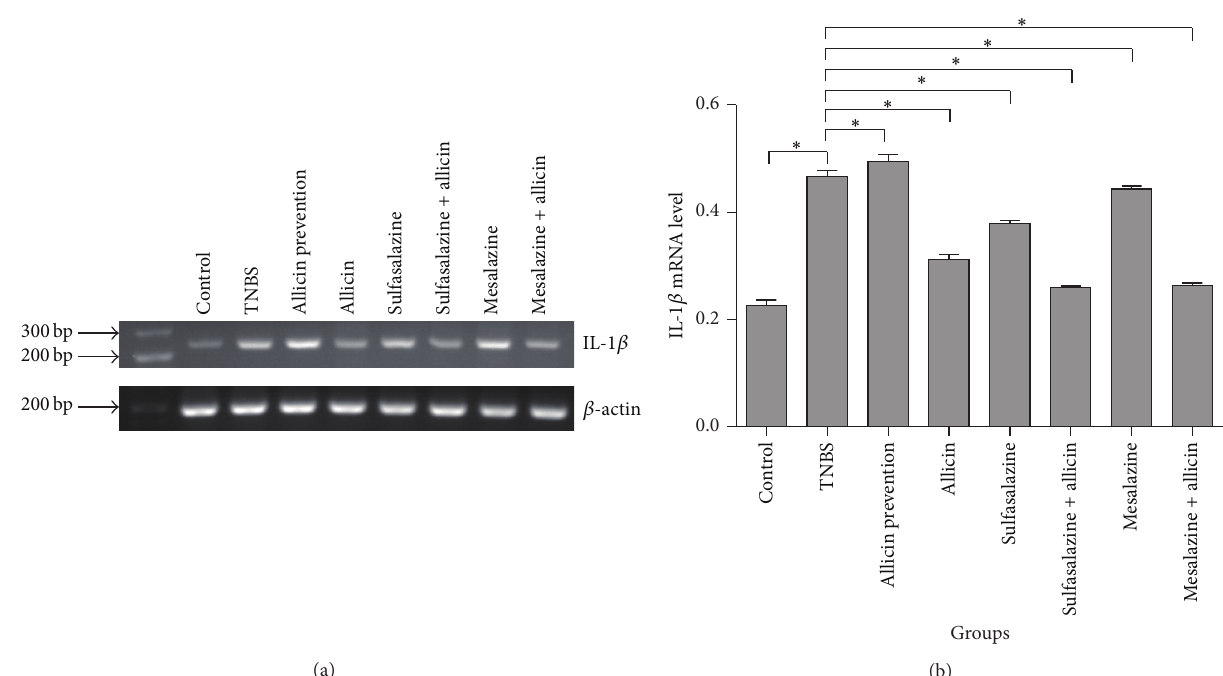
Figure 4: Expression of colon IL-1 𝛽 mRNA level in rats. (a) Total RNA was isolated from colon tissue. Colon IL-1 𝛽 mRNA levels were presented on an agarose gel. (b) The gel was carried out by densitometric and statistical analysis. Results were reported as means ± SD from 3 independent experiments. ∗ 𝑃 < 0.01 versus TNBS group.